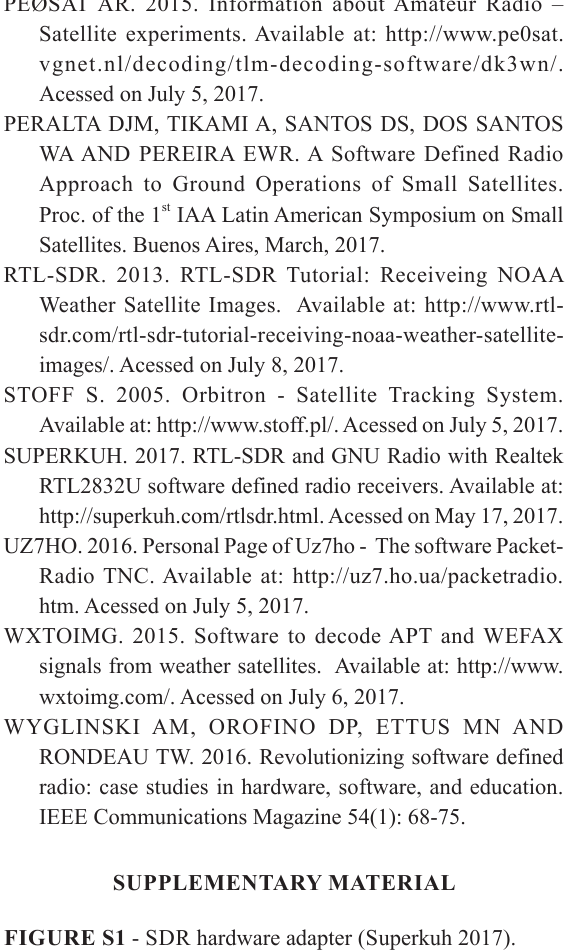
FIGURE S1 - SDR hardware adapter (Superkuh 2017). FIGURE S2 - Funcube Dongle Pro Plus connected to computer. FIGURE S3 - Heavens-Above app screens on passing-by satellites. FIGURE S4 - SDR sharp screen with spectrum of received signal. FIGURE S5 - Soundmodem application converting raw data into binary. F IGURE S6 - AGW Online Kiss program with raw and configuration file. FIGURE S7 - Schematic diagram for the telemetry decoding progress. FIGURE S8 - A typical ground station block diagram. FIGURE S9 - Schematic diagram for image reception of images from NOAA satellites. FIGURE S10 - Final image obtained from NOAA-19